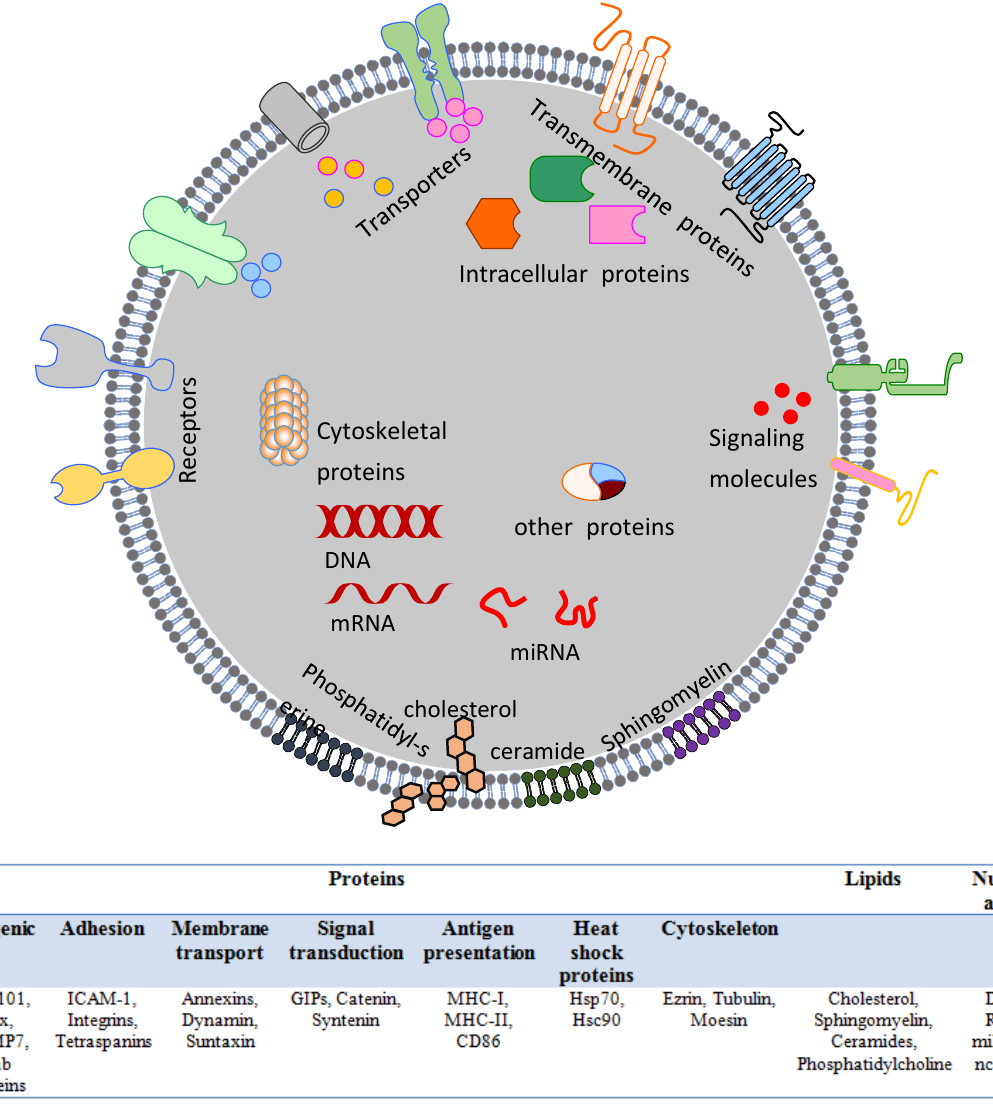
Figure 2. Structure of an exosome. Exosomes exhibit a complex lipid-bilayer surface structure characterized by an array of surface-localized proteins and membranous lipids, which mediate specific targeting and promote cellular uptake.